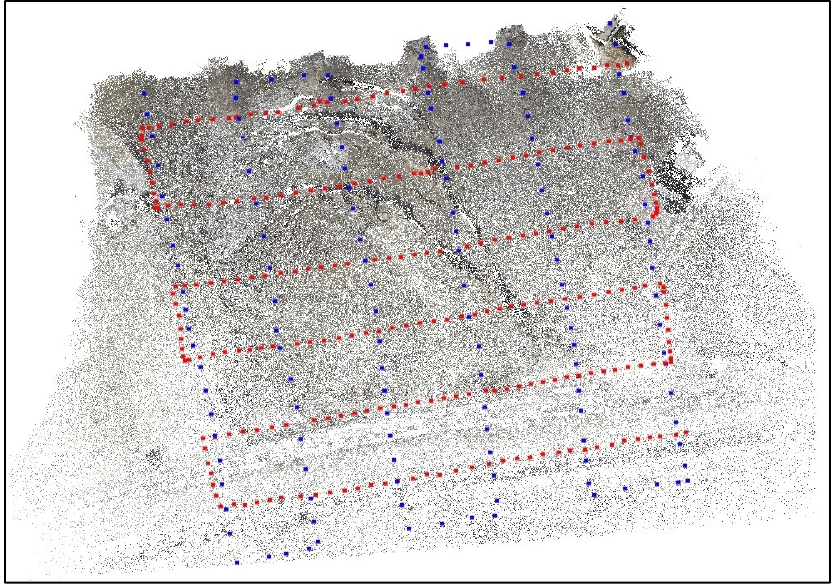
Figure 11. Perspective view of the constructed sparse point cloud. The red (North to South direction) and blue (East to West direction) dots over the sparse points show the camera positions and orientations during image acquisition by the UAV.